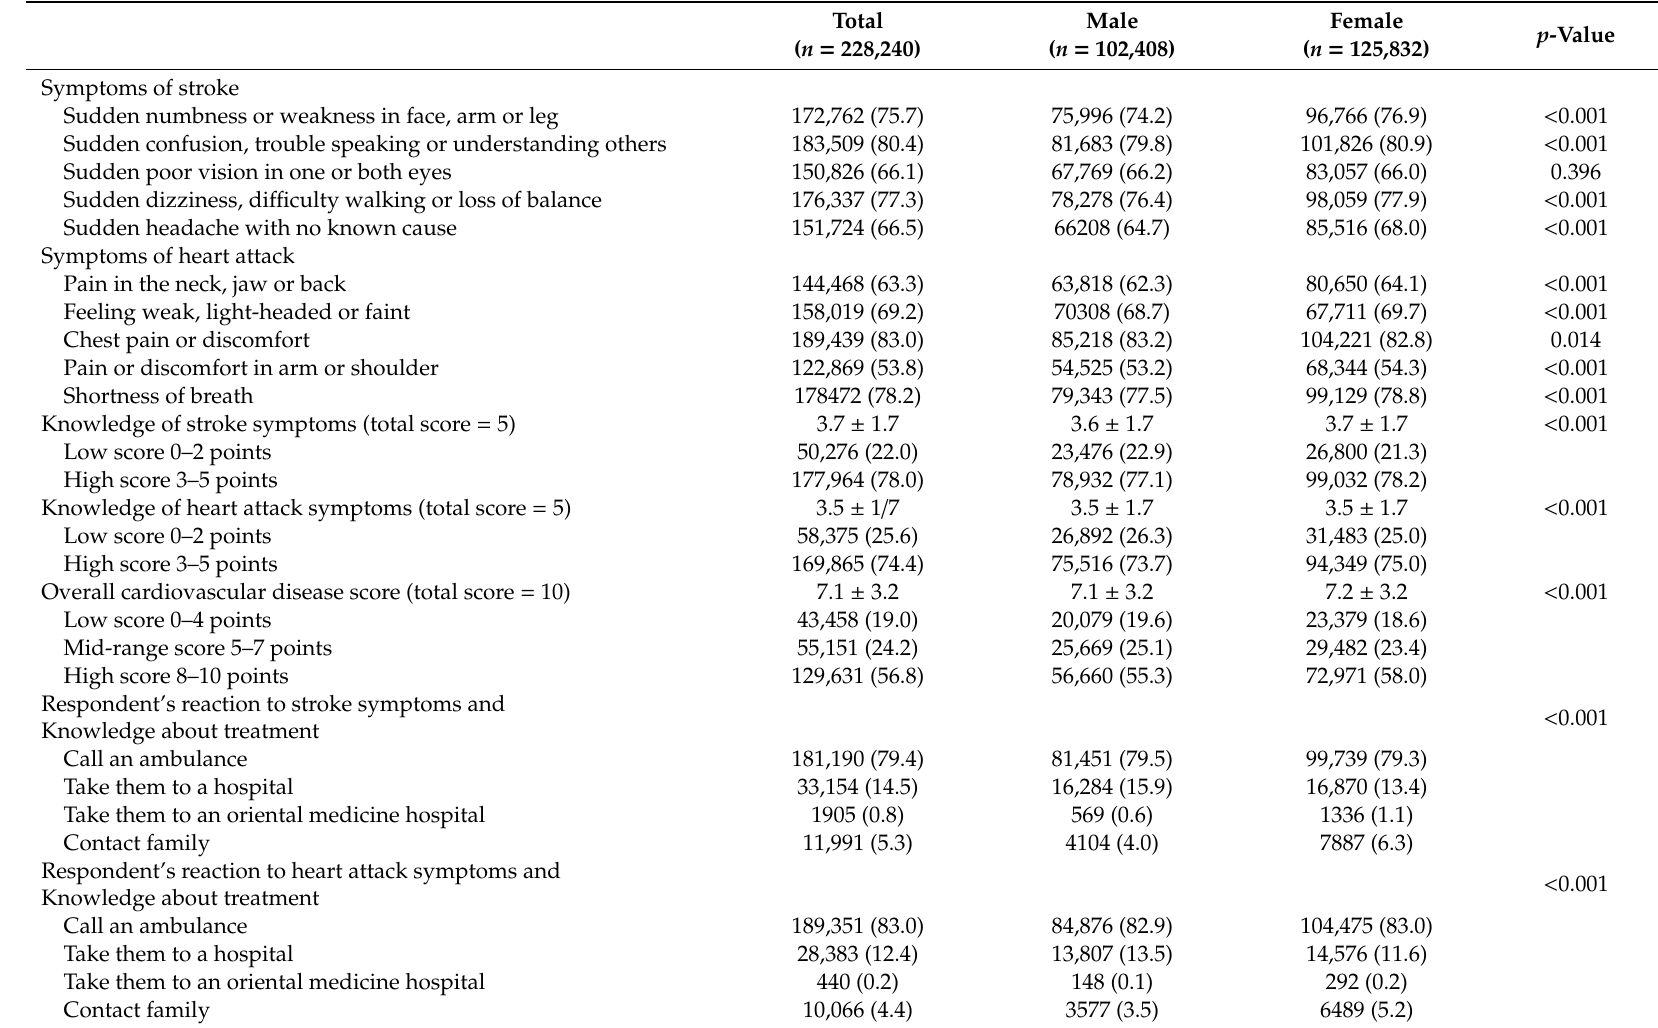
Table 2. Knowledge about symptoms of heart attack and stroke according to sex among